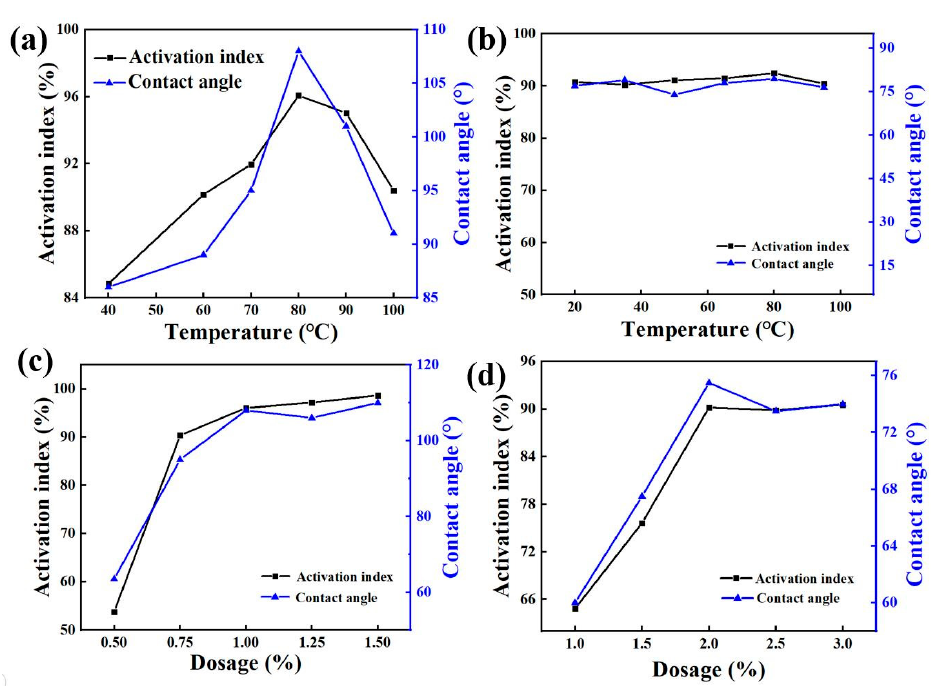
Figure 1. Effect of temperature on modification under the action of Octadecylamine ( a ) and Dodecyl tertiary amine ( b ); effect of dosage of Octadecylamine ( c ) and Dodecyl tertiary amine ( d ) on modification.